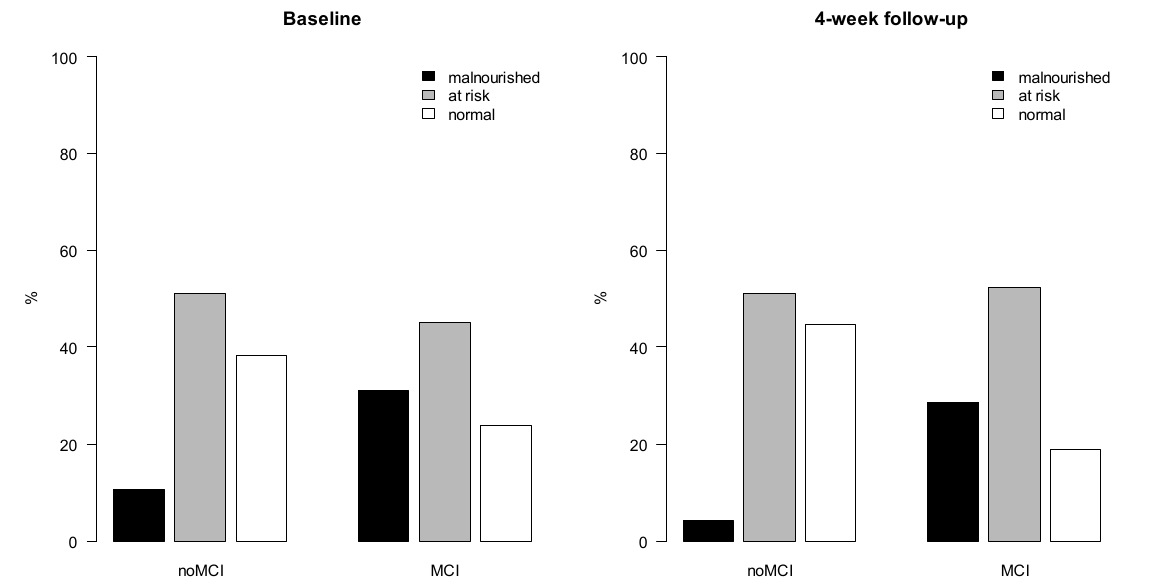
* Baseline measurement, a BMI = Body Mass Index; b EQ-5D-5L = EuroQol–5 Dimensions–5 Levels, c VAS = Visual Analogue Scale, d MMSE = Mini Mental State Examination.